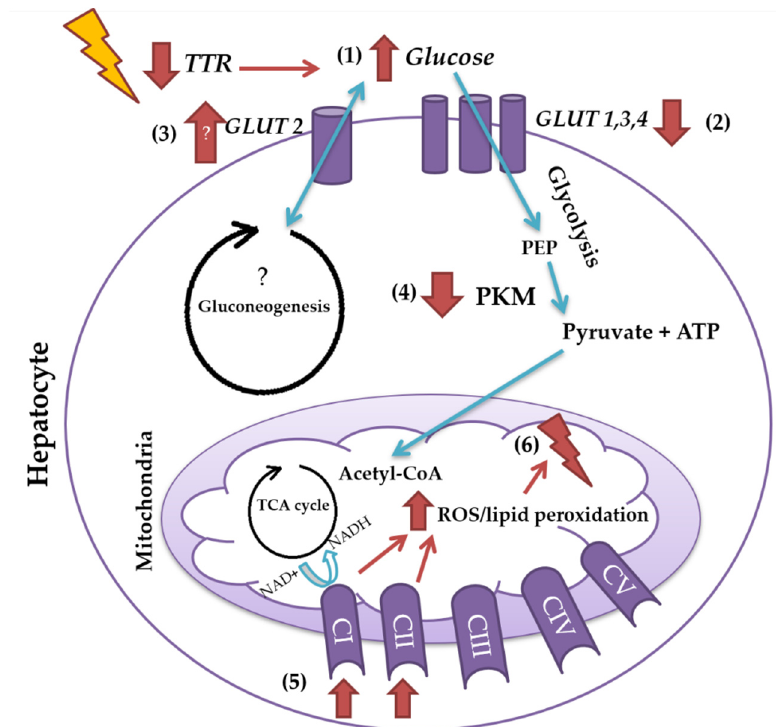
Figure 5. Graphical summary of the results obtained in the present study, illustrating the effects of TTR insufficiency on glucose metabolism of the liver. Insufficiency of TTR, which can result from its tetrameric instability and consequent increased clearance, can increase extra-hepatic glucose lev- els (1), which can be, at least partially, due to its negative effect on the expression of influx glucose transporters, GLUT1, GLUT3, and GLUT4 (2) and increased expression of efflux glucose trans- porter, GLUT2 (3). Moreover, the decrease in the expression of glycolytic enzyme, PKM (4), and the increase in mitochondrial CI and CII of the electron transport chain (5) are observed in the TTR haploinsufficiency mouse model, which in turn leads to higher levels of ROS and/or lipid peroxida- tion and ends up compromising the mitochondrial density and function